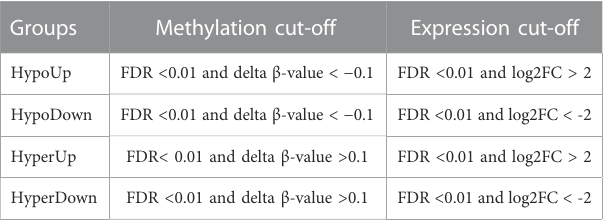
TABLE 1 Criteria for grouping DMEGs.